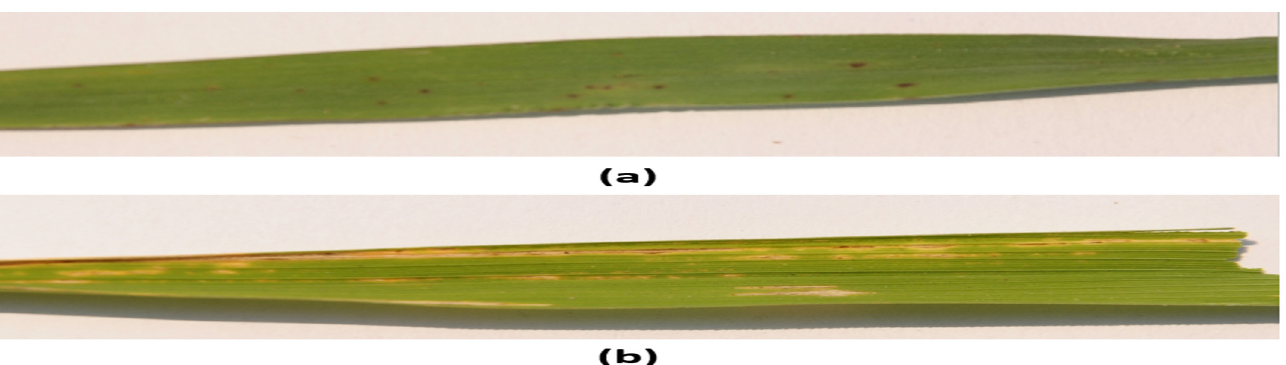
Table 1. Original Dataset.